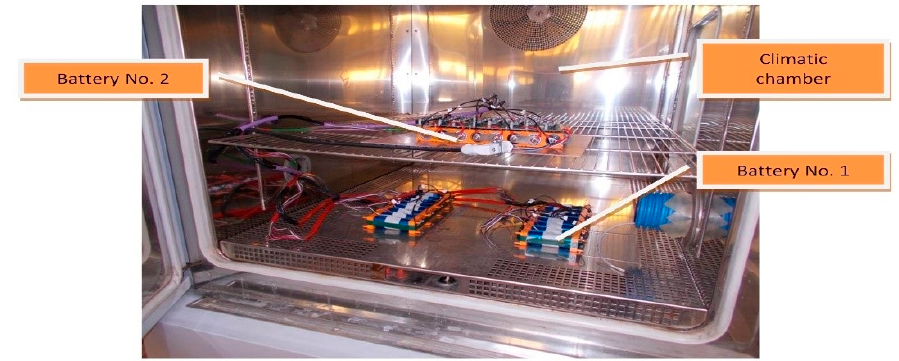
Figure 13. V iew of the battery pack arrangement for tests with active BMS in the climatic.